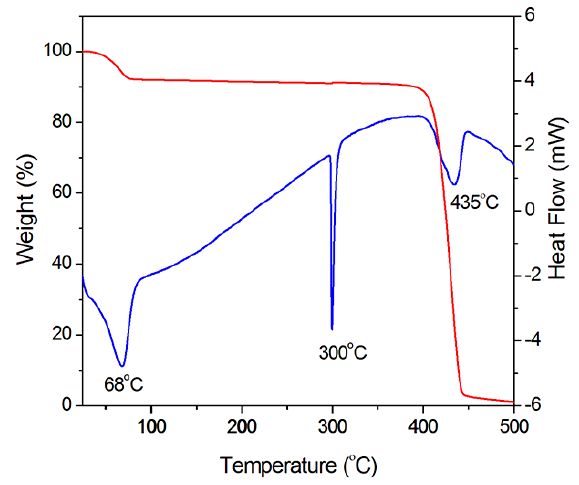
Figure 4. TG-DTA curves of TPPB (2H 2 O).